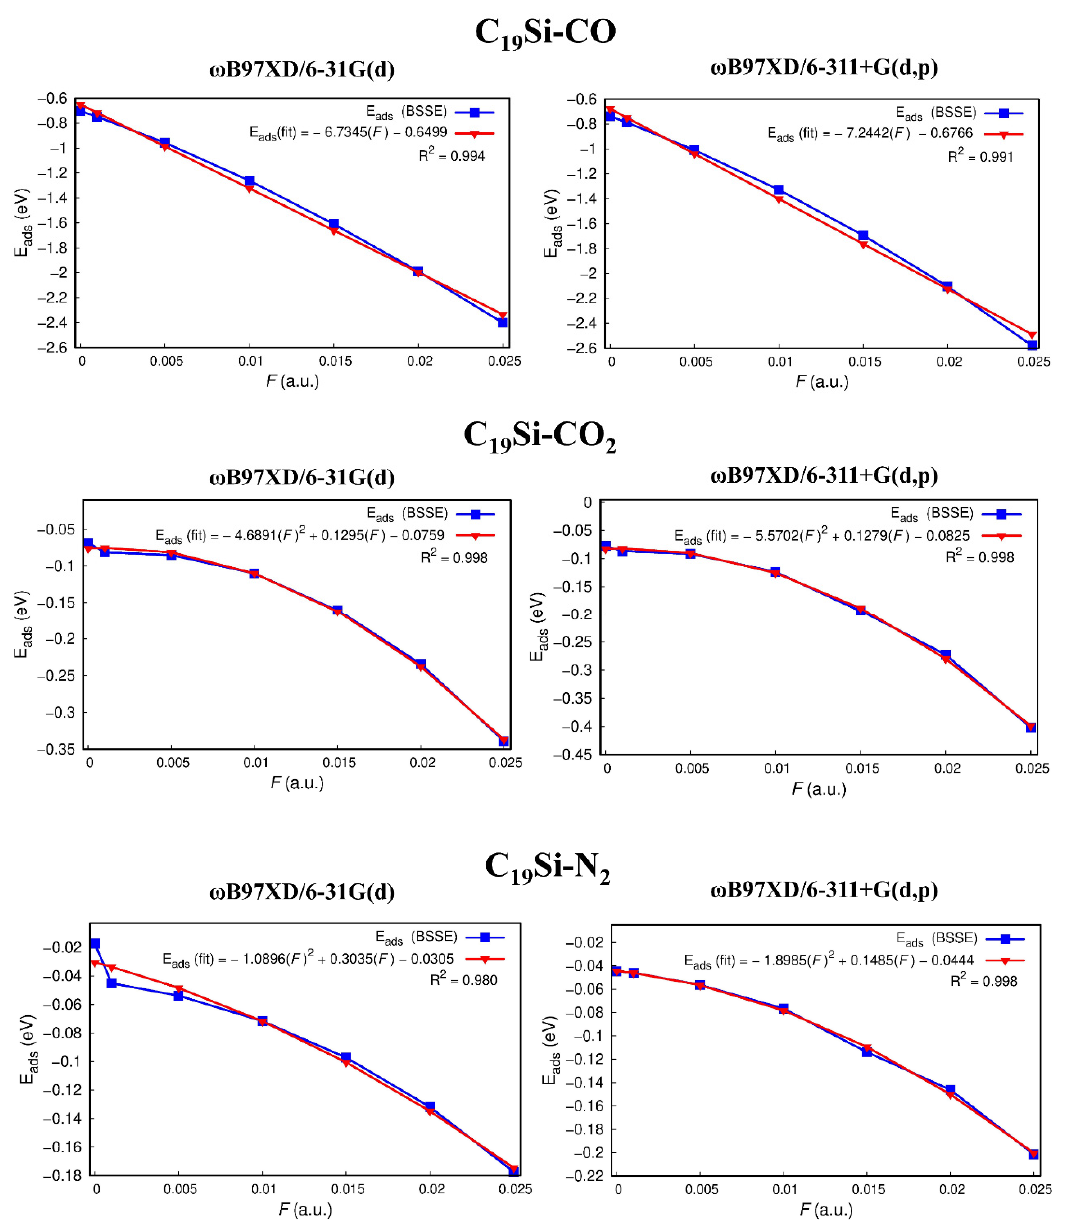
Figure 4. Theoretical, 𝐸 (cid:3028)(cid:3031)(cid:3046) , and fitted, 𝐸 (cid:3028)(cid:3031)(cid:3046) (𝑓𝑖𝑡) , adsorption energies as a function of the electric field, 𝐹